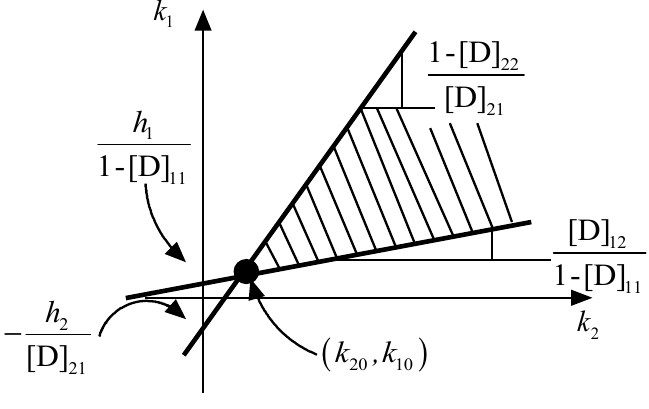
Figure 1. Graphical solution for k 1 and k 2